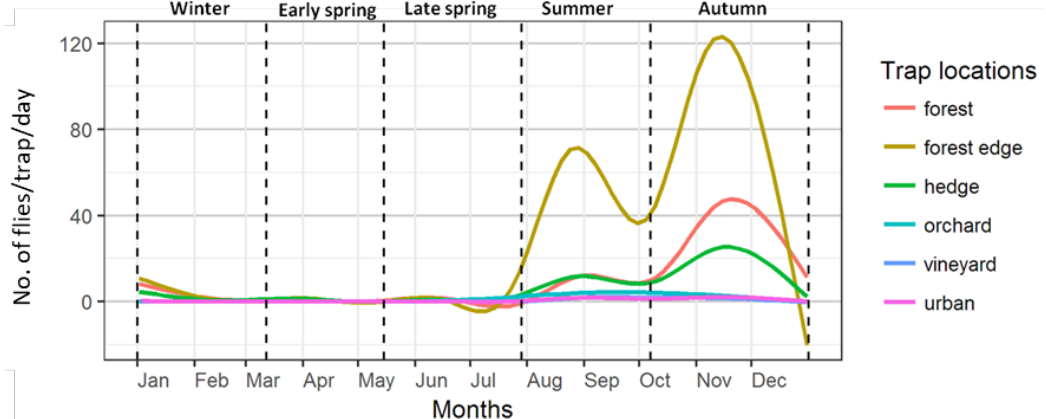
Figure 3. Smoothed LOESS curves of daily trap captures in different habitat types from 2011–2017. The vertical dotted lines mark the phenology phases (top; see Table 2 for a description). Insects 2018 , 9 , x FOR PEER REVIEW